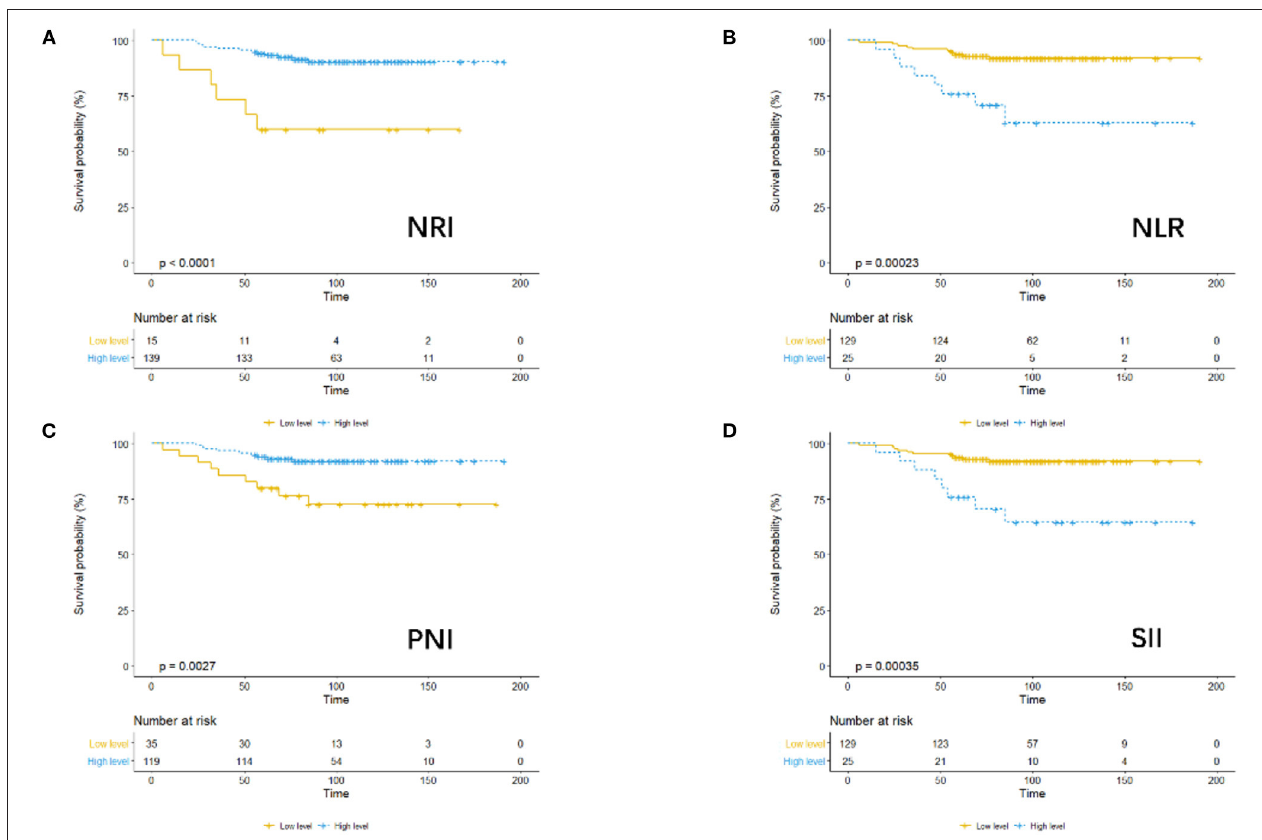
FIGURE 1 | KM analysis of NRI (A) , NLR (B) , PNI (C) , and SII (D) based on overall